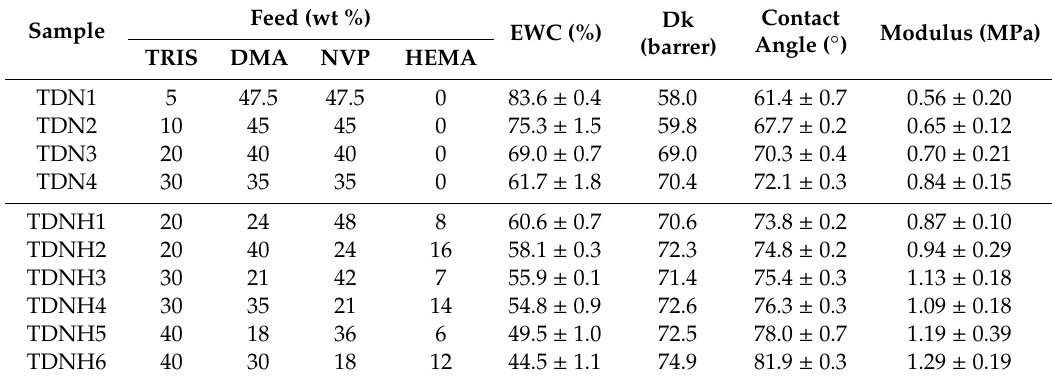
Table 1. Formulations of silicone hydrogel by copolymerization of TRIS, DMA,